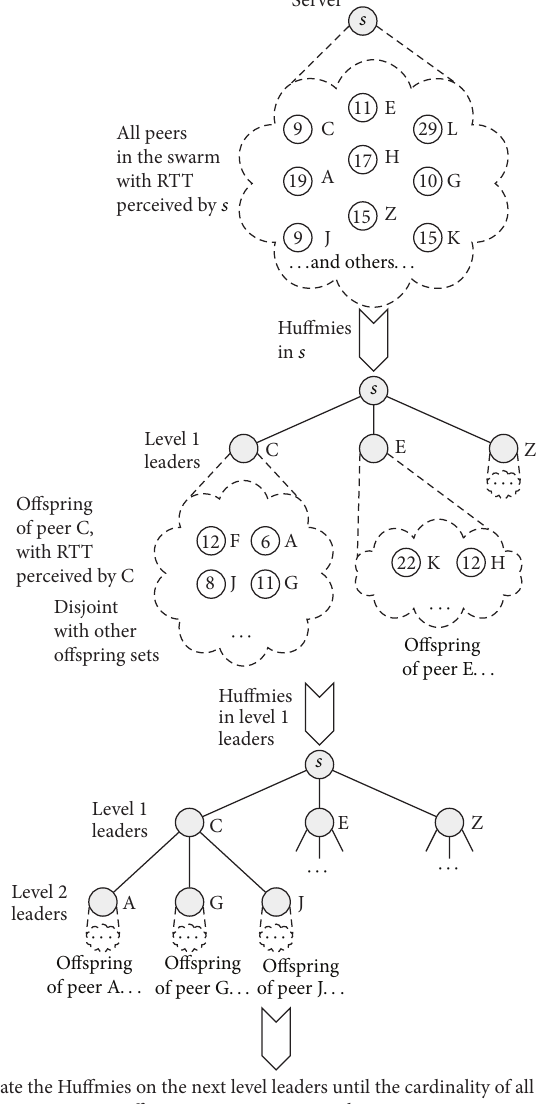
Figure 4: Overview of the consecutive stages in the fully distributed Huffmies approach. Values in circles denote 𝑝(𝑖)